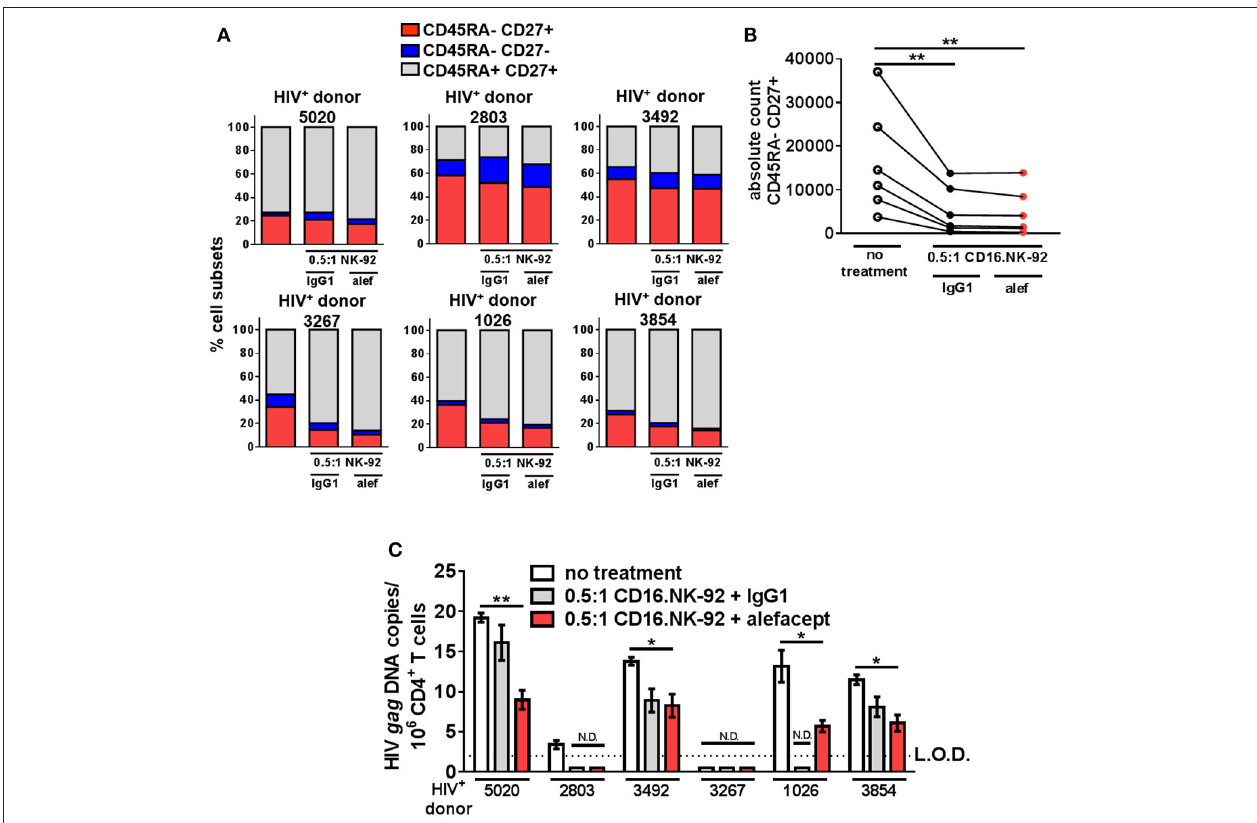
FIGURE 6 | CD16.NK-92 and alefacept significantly reduce HIV DNA in vitro . (A) Percent of whole representation of CD4 + T cell memory subsets by HIV + donor with no treatment, after 3 day co-culture with CD16.NK-92 and 10 µ g/mL alefacept or IgG1 control antibody. (B) Absolute counts of CD27 + CD45RA– T( CM / TM ) subset in HIV + donors after 3 days in co-culture with CD16.NK-92 and 10 µ g/mL alefacept or IgG1 control antibody. (C) HIV DNA copies per million CD4 + T cells as measured by quantitative PCR, with no treatment or after 3 day co-culture with CD16.NK-92 and 10 µ g/mL alefacept or IgG1 control antibody. Samples in which HIV gag DNA was not detectable are indicated with N.D. Dotted line represents the limit of detection (L.O.D.) of 2 copies of HIV gag DNA copies/10 6 CD4 + T cells. Mean and SEM shown for 3 qPCR reactions of same sample and 6 HIV + donors, * P ≤ 0.05, ** P ≤ 0.01.